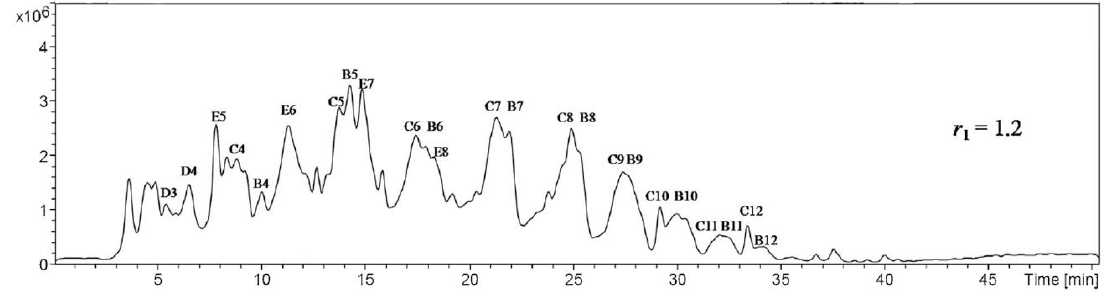
Figure 26. Total ion chromatogram (TIC) of vinyl siloxanes oligomers at a molar ratio (water/silane)